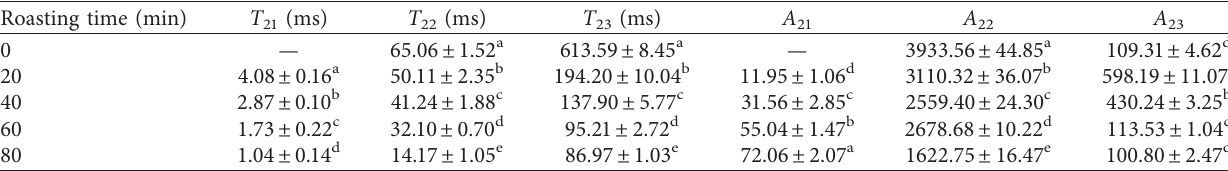
Table 4: T 2 relaxation time of Chinese giant salamander jerky as affected by roasting time.